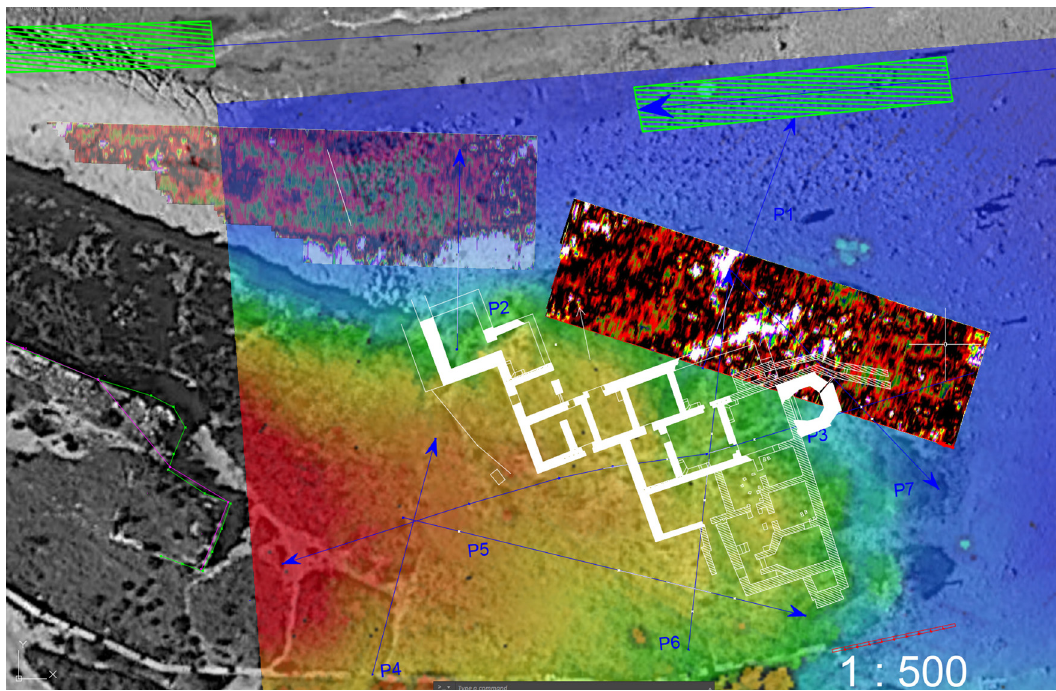
Figure 11: Overlay of 1911 plan, GPR survey and LiDAR survey over Google Earth base map of the site.